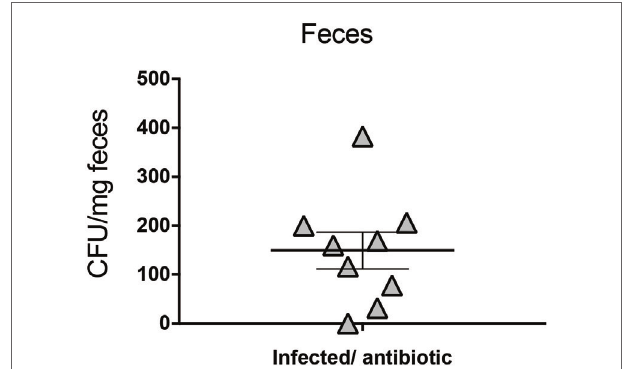
FigUre 4 | Salmonella enterica serovar Typhimurium ( S. Typhimurium) is excreted in feces after 39 days of infection in wild type (WT) mice, despite enrofloxacin treatment. C57BL/6 WT mice were infected with 1 × 10 5 CFU of S. Typhimurium WT. Four days post-infection (days p.i.) mice were orally treated with enrofloxacin (2 mg/ml) for 3 weeks, and then left untreated for 14 days. Bacterial loads were quantified at 39 days post-infection by seeding feces into Salmonella-Shigella agar, as described in Section “Materials and Methods.” Data shown include two separated experiment, nine mice in